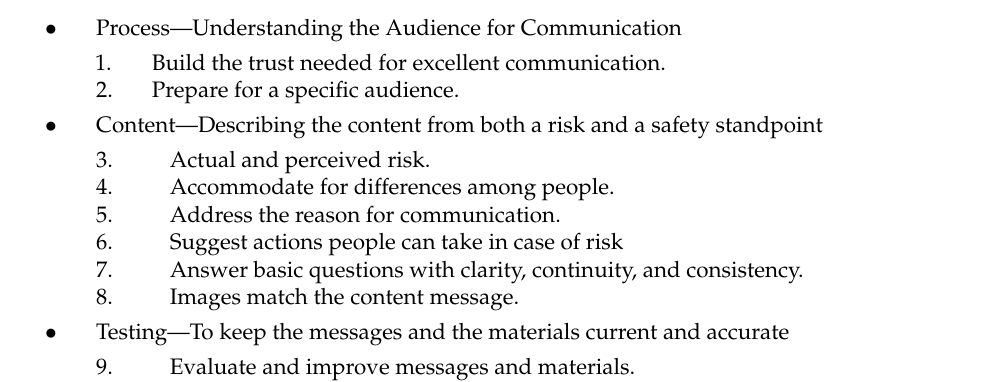
Table 5. Nine Principles of Risk and Safety